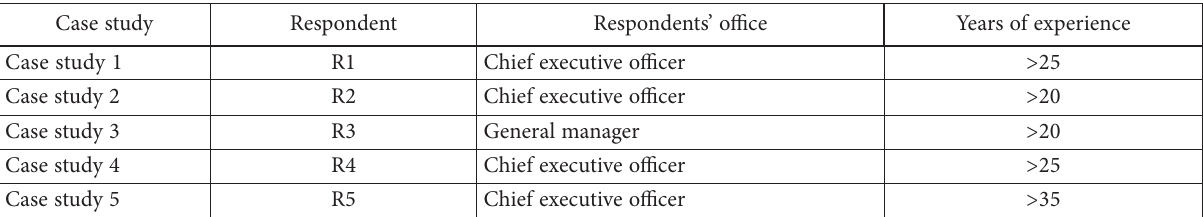
Table 1. Case studies and